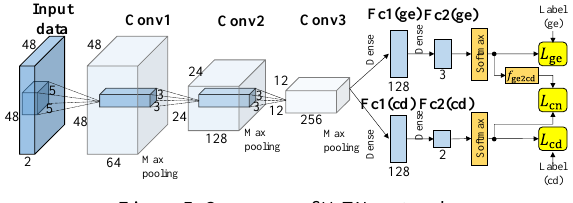
Figure 5. Summary of MTN